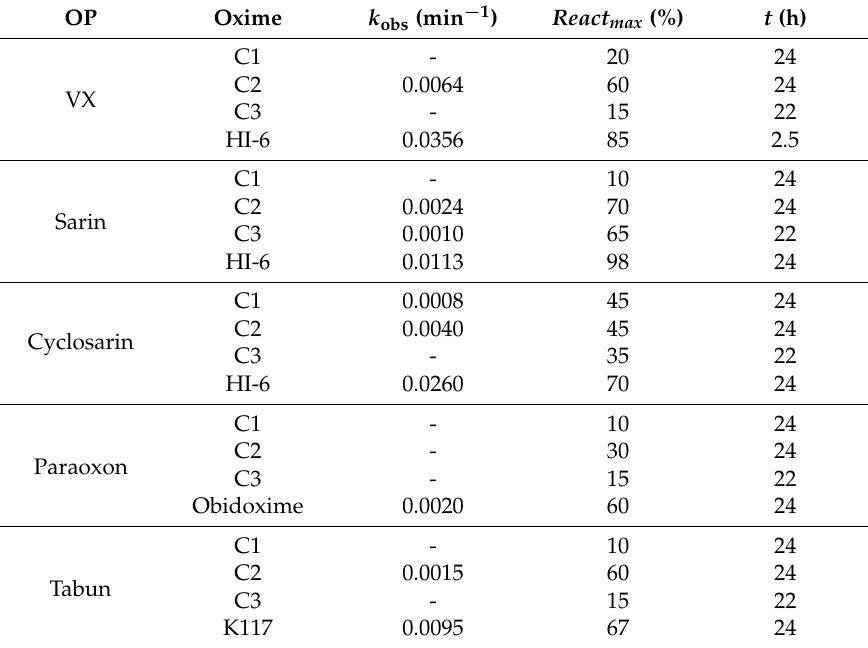
Figure 4. Screening of OP-inhibited human butyrylcholinesterase (hBChE) reactivation by 0.1 mM oximes C1, C2 and 0.05 mM C3 at 25 °C. Results in terms of maximal obtained reactivation percentage within 22–24 h are presented as a mean of two to three experiments (experimental deviation was less than 10%). Table 1. Screening of OP-inhibited hBChE reactivation by 0.1 mM oximes C1, C2 and 0.05 mM oxime C3. Observed reactivation rate constants ( k obs ), maximal reactivation ( React max ) obtained in time ( t ) are presented as the mean value of two experiments.